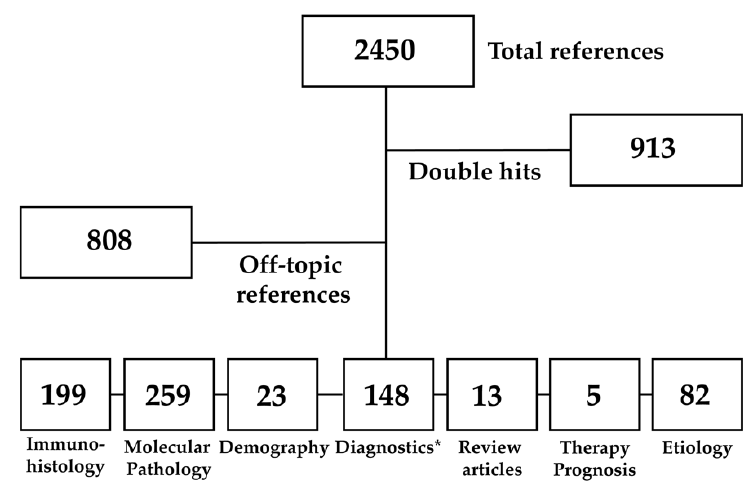
Figure 1. Summary of our literature search. * Diagnostics include noninvasive diagnostic approaches (laboratory diagnostics, medical imaging).